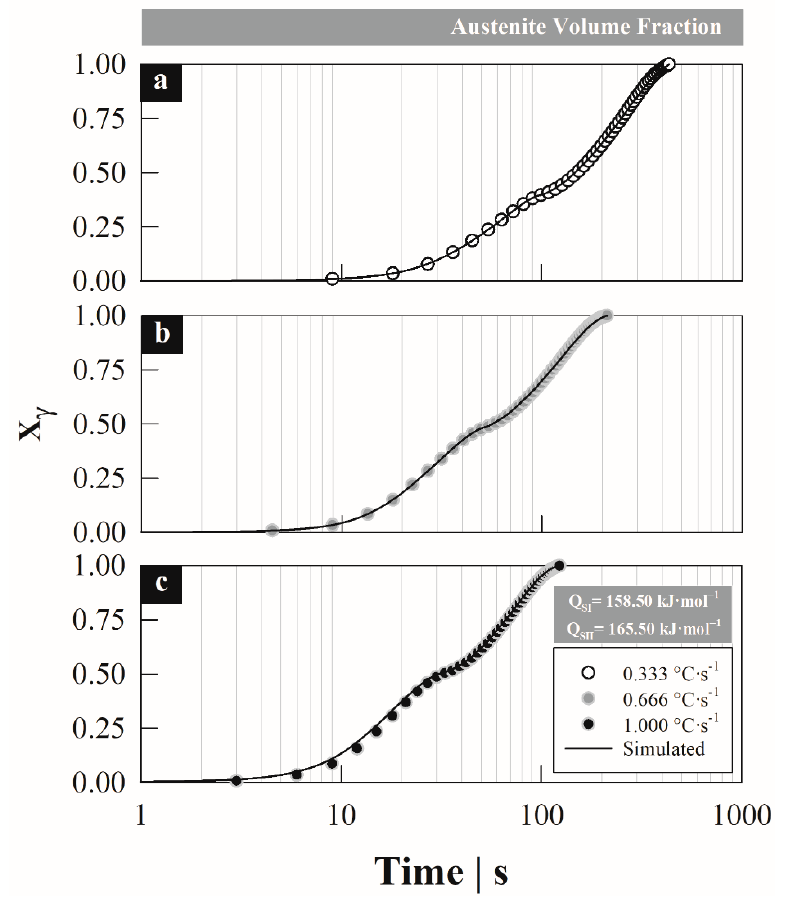
Figure 10. Correction of the total austenite formation degree estimated with the non-isothermal model, minimizing the root-mean-square error between the estimated and experimental data by activation energy in stages at different heating rates: ( a ) 0.33, ( b ) 0.66 and ( c ) 1.00 °C s − 1 . The figures show an acceptable fit with a minimum error when comparing the estimated with experimental data, when using an activation energy of Q S − I = 158.50 kJ·mol − 1 and Q S − II = 165.50 kJ·mol − 1 , for the first and second formation stage, respectively. These energies minimize the error between the estimated and experimental data, RMSE 0.33 = 6.99 × 10 − 3 , RMSE 0.66 = 1.92 × 10 − 3 and RMSE 1.0 = 9.12 × 10 − 3 (superscripts indicate heating rate). correspond to the energy associated with the driving force for the austenite formation; i.e.,